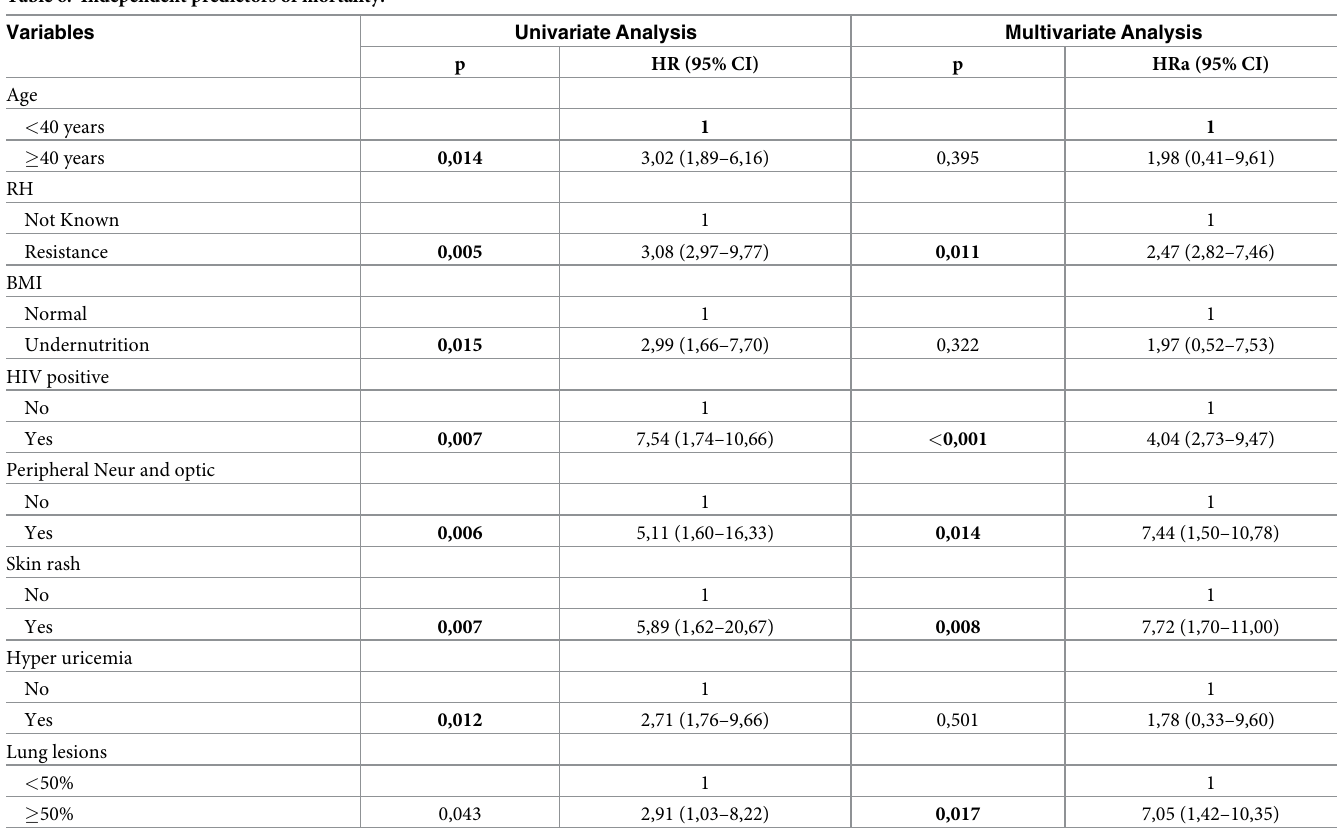
Table 6. Independent predictors of